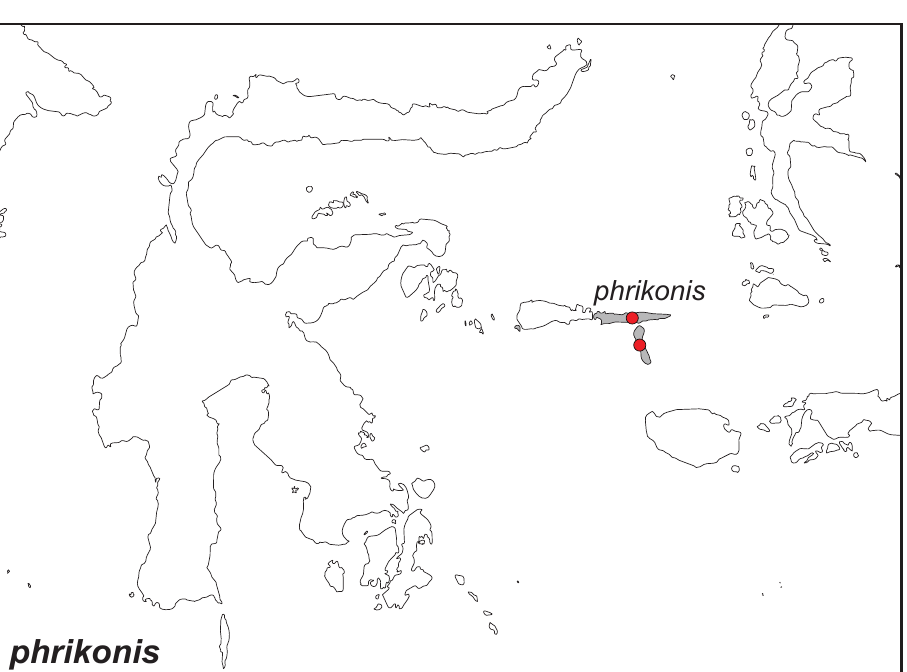
Figure 73. Distribution map of Elymnias bornemanni .